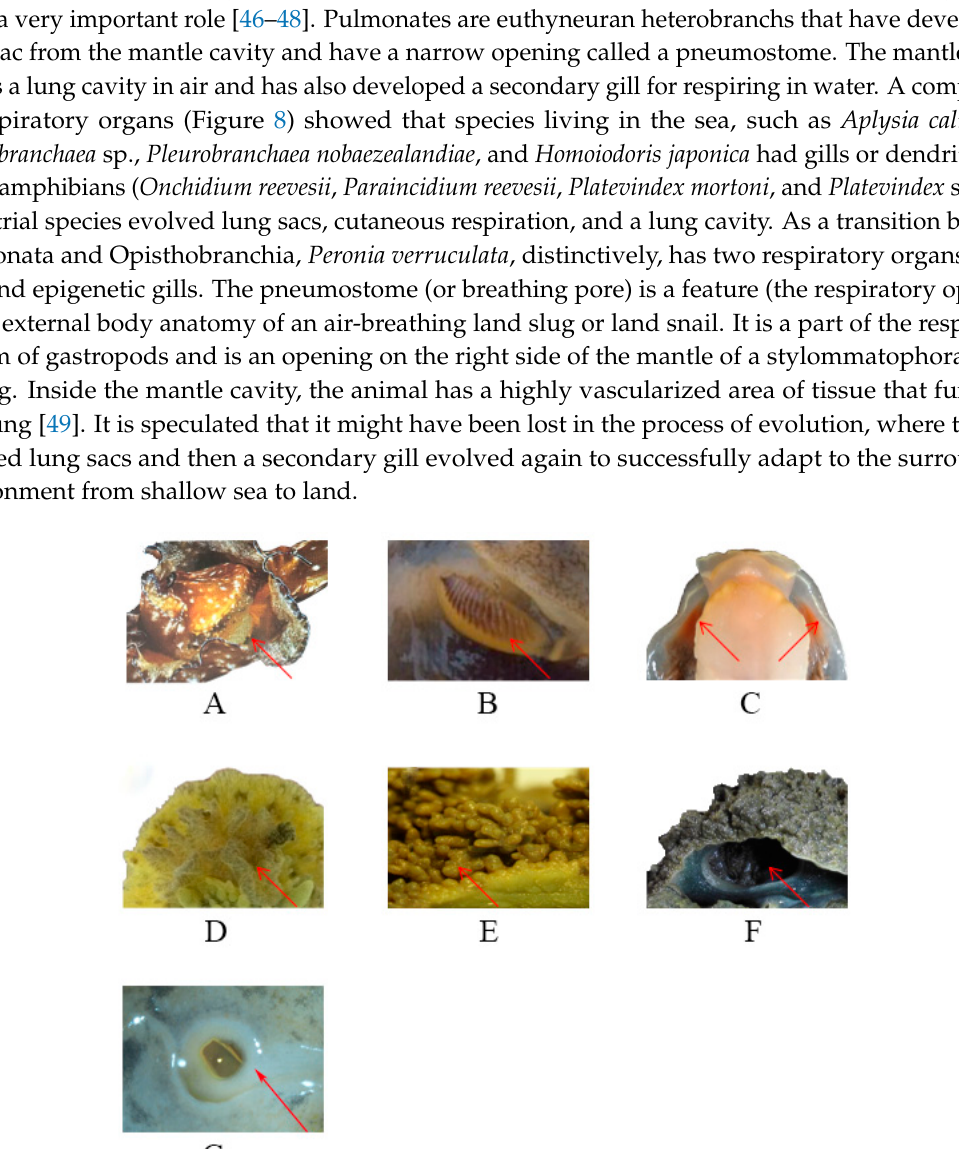
Figure 8. The biological evolution trend of respiration: ( A ) Aplysia californica ; ( B ) Pleurobranchaea nobaezealandiae ; ( C ) Pleurobranchaea sp.; ( D ) Homoiodoris japonica ; ( E ) Peronia verruculata ; ( F ) Onchidium reevesii ; ( G ) P. bilineatus